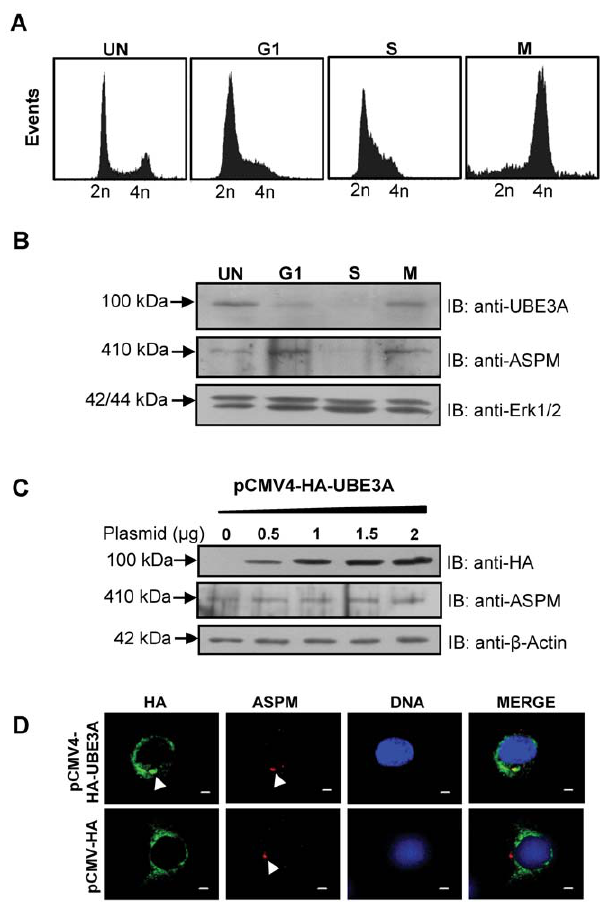
Figure 5. UBE3A is a cell cycle dependent protein and it fails to degrade ASPM. (A) Flow cytometric analysis of cells to confirm synchronization in different cell cycle phases. Note the cells in G1 phase show a 2n peak, cells in M phase with a 4n peak and cells in S phase fall in between 2n-4n peaks, suggesting cell cycle arrest at these phases. UN: unsynchronized cells. (B) HEK293 cells synchronized at different cell cycle phases were analyzed for UBE3A and ASPM expression by Western blot analysis. Note the expression of UBE3A was found to peak in M phase as compared to its levels in G1 and S phases. The level of ASPM peaks during G1 and M phases. Erk1/2 was used a loading control. The level of Erk1/2 is known to remain unaffected during different phases of cell cycle. (C) Western blot analysis of lysates from HEK293 cells transfected with an increasing concentration of the pCMV4-HA-UBE3A construct. Note UBE3A overexpression fails to degrade ASPM. Overexpression of UBE3A was determined by probing the blot with anti-HA antibody. b -Actin was used as a loading control. (D) Immunofluorescence analysis of HEK293 cells overexpressing the pCMV4-HA-UBE3A construct. UBE3A and ASPM staining were examined by anti-HA and anti-ASPM antibodies respectively. Note overexpression of UBE3A does not alter ASPM localization or protein level (compare ASPM signals in upper and lower panels). Also note colocalization of UBE3A with ASPM at the centrosome (upper panel). Cells transfected with the pCMV-HA vector were also stained with anti-HA antibody as a control (lower